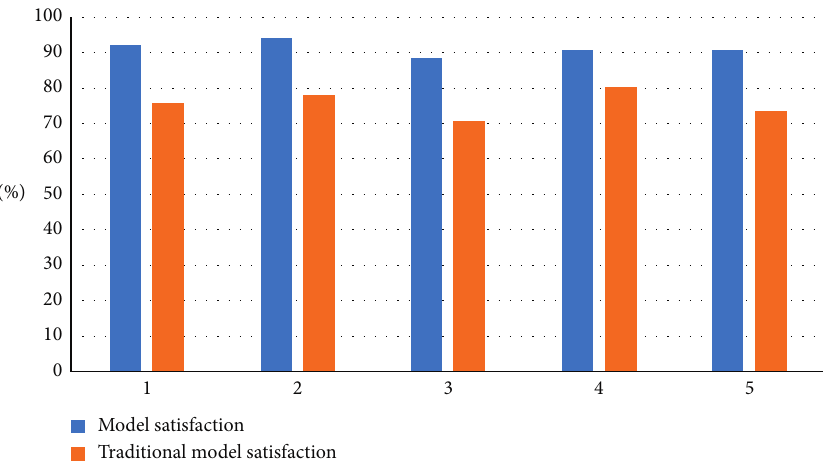
Figure 6: Comparison results of satisfaction between the model in this paper and the traditional